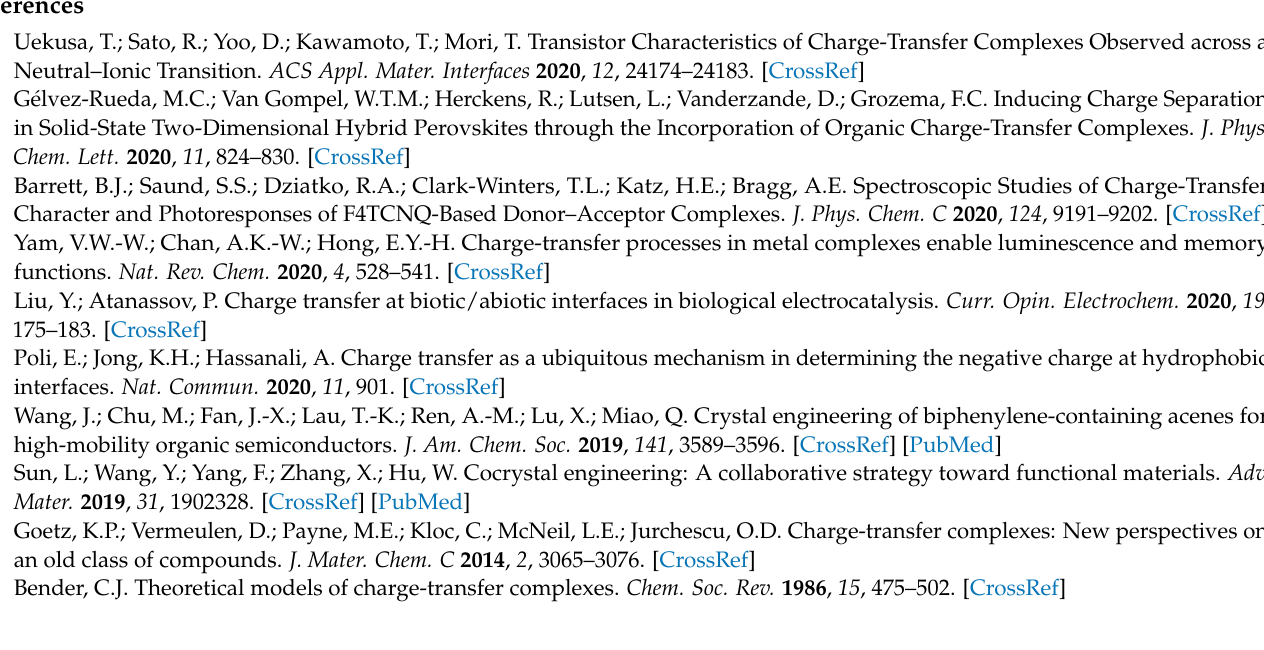
Table S5: the optimized structure of BUChA-I, Table S6: Calculated Frequencies of BUChA-I; Table S7: the optimized structure of BUChA-II, Table S8: Calculated Frequencies of BUChA-II, Table S9: the optimized structure of BUChA-I/g-C 3 N 4